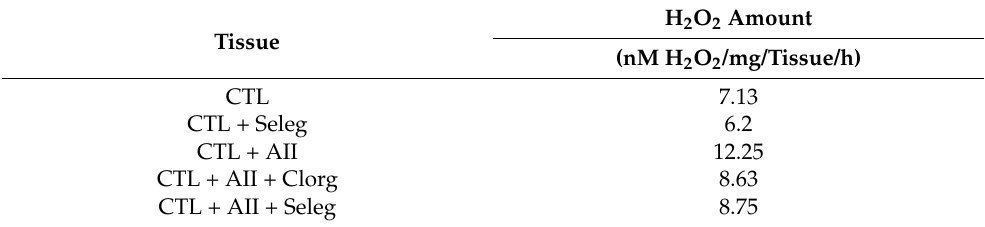
Figure 4. Assessment of superoxide (bright red) in the explanted mitral valve by confocal microscopy (DHE staining) in the presence of AII, clorgyline, and selegiline. Table 2. Assessment of H 2 O 2 in the explanted mitral valve by spectrophotometry (FOX